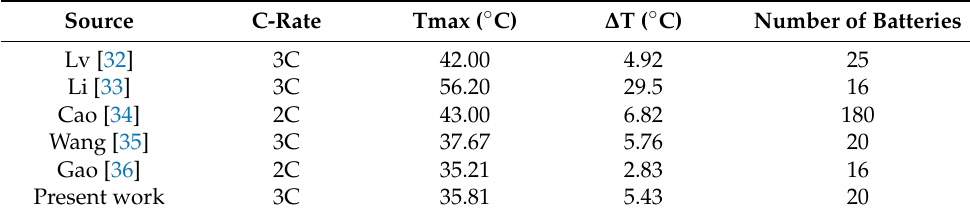
Table 3. Comparison with the published work on liquid cooling of battery modules.